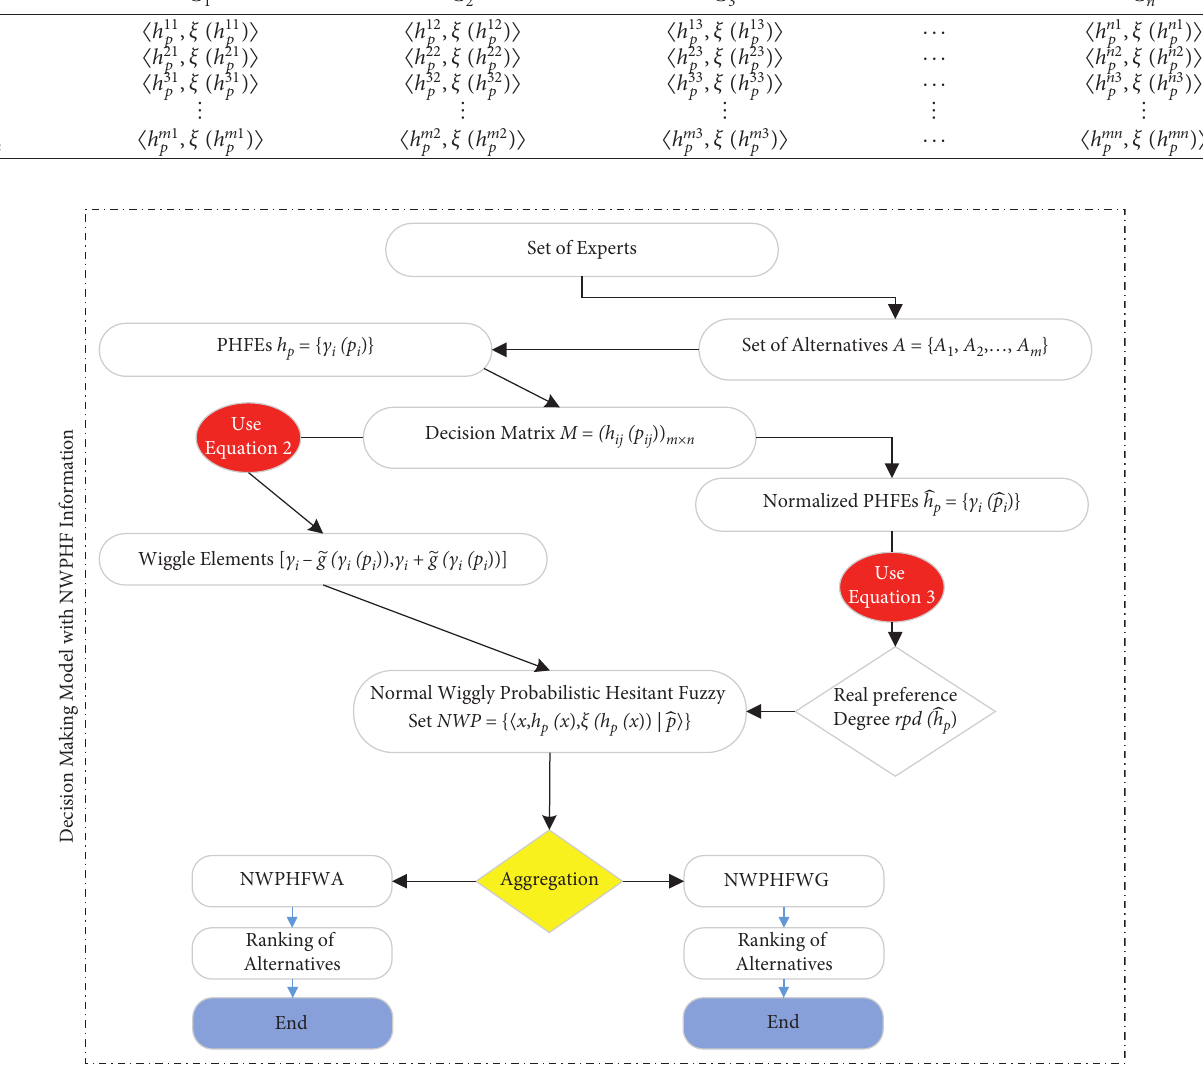
Figure 1: The schema of the whole decision-making steps using the normal wiggly probabilistic hesitant fuzzy